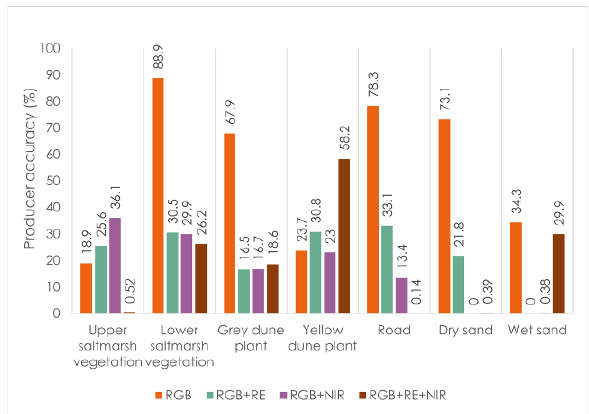
Figure 12 . Barplot of the producer accuracy of e infrared predictors contributions on the basis RGB at class level (upper and lower saltmarsh, grey and yellow dune plant, road, dry and wet sand) computed with each class with convolutional neural network (CNN)